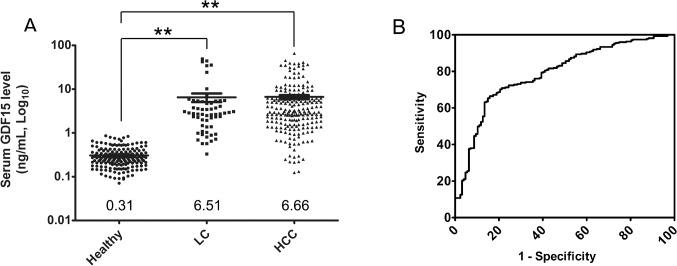
Serum GDF15 is increased in patients with LC or HCC.
(A) Scatter plots show the serum GDF15 levels in healthy (n = 202), LC (n = 88) and HCC (n = 223) patients by ELISA. The black line indicates the mean, for which the value is indicated at the bottom of the scatter plot. ** indicates that P < 0.0001 for both LC and HCC compared with healthy controls. (B) The GDF15 ROC curve is plotted to compare the HCC or LC patients versus HBV or HCV carriers.